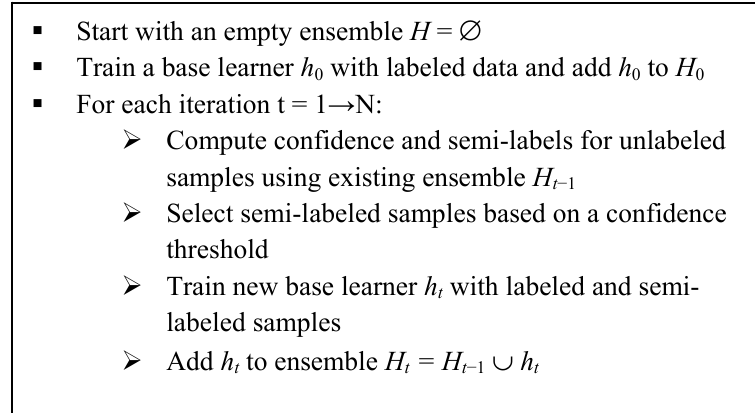
Scheme 1. General outline of SSL bagging ensemble